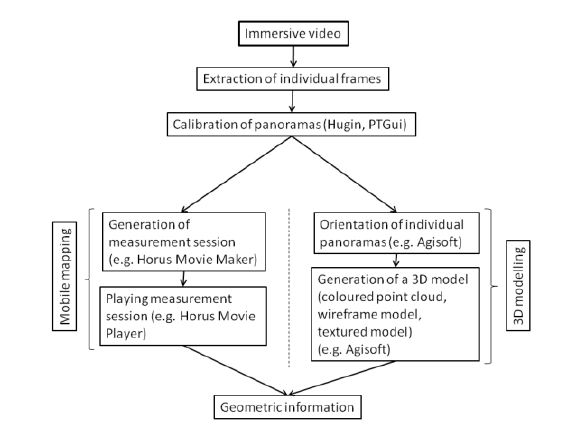
Figure 5. The process of applying photogrammetric measurements in immersive video.